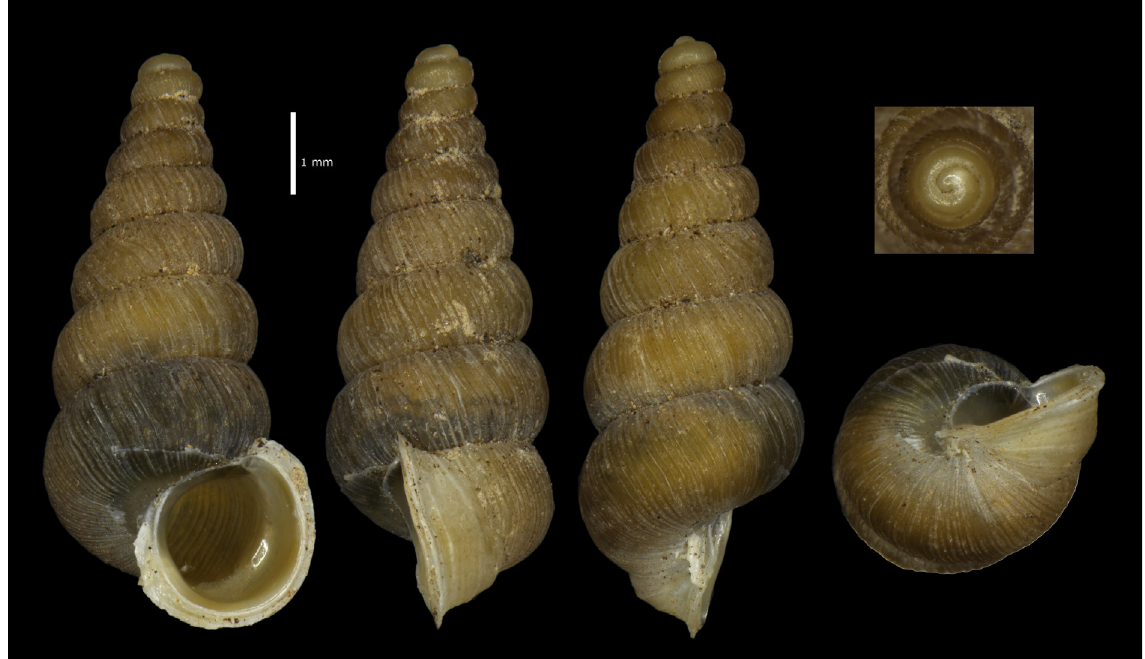
Fig. 11. Cochlostoma (Lovcenia) jakschae Zallot, Fehér & Gittenberger sp. nov., holotype, Bugarska Peak, Macedonia (NHMW